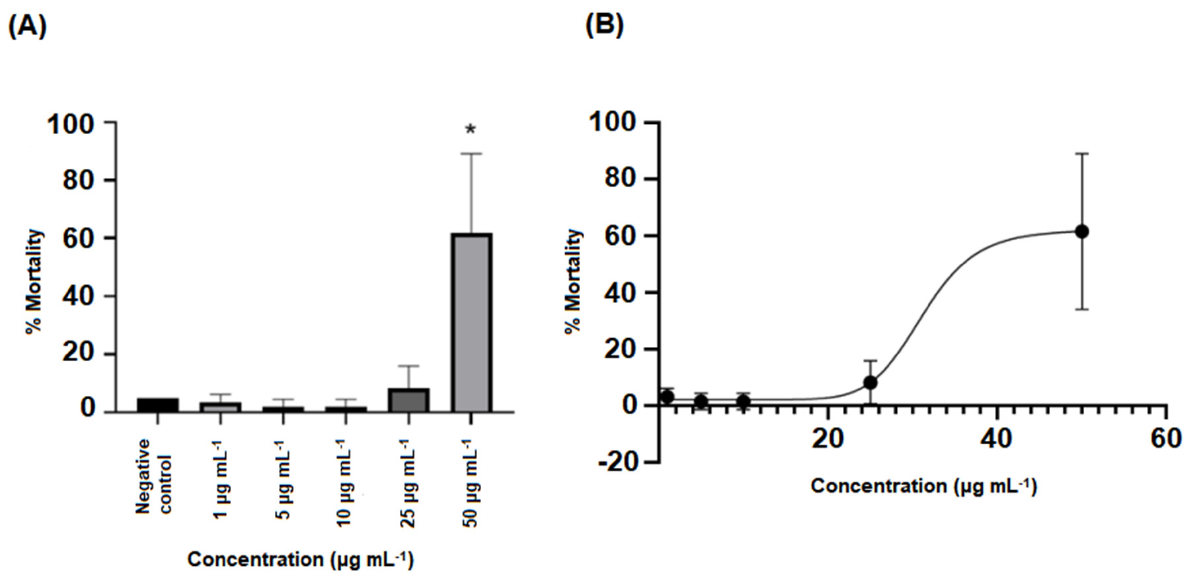
Figure 2. ( A ) Graph of the mortality rate of D. rerio embryos exposed to the negative control and to concentrations of 1, 5, 10, 25, and 50 µg mL − 1 of microcyclamide for 96 h and ( B ) dose–response curve obtained after 96 h of exposure. The error bars indicate the SD of the means ( n = 3). (*) Dunnett’s test was used, with p < 0.05.